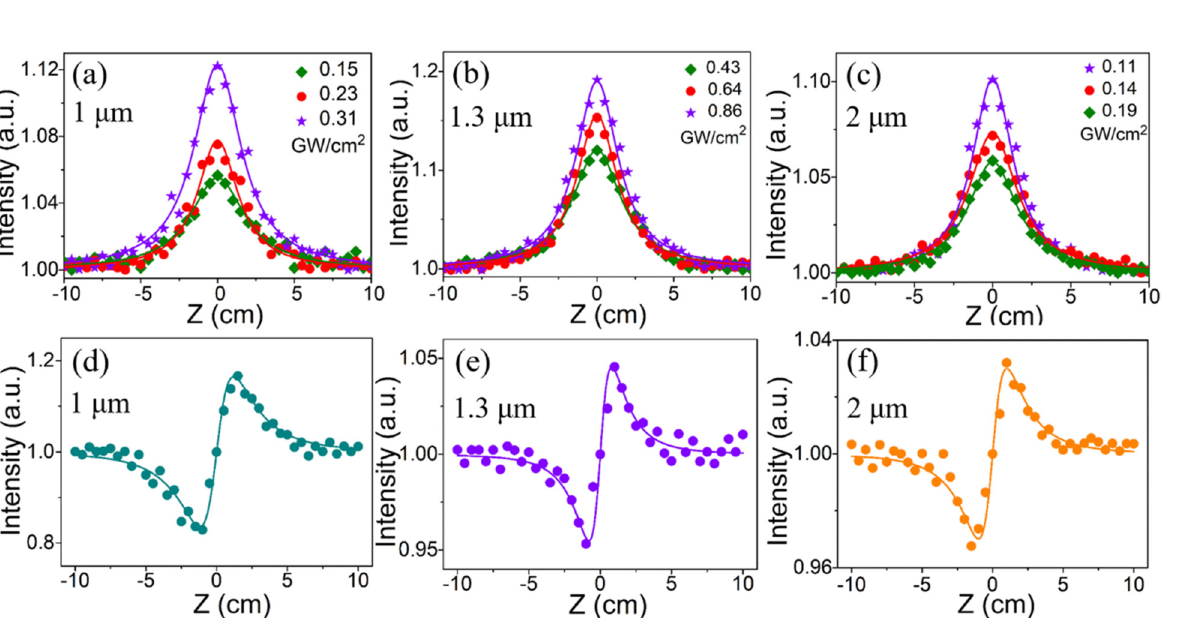
Figure 3: OA Z-scan results of S-C 3 N 4 at (a) 1.06, (b) 1.34, and (c) 1.87 μ m, respectively. CA Z-scan results of S-C 3 N 4 at (d) 1.06, (e) 1.34, and (f) 1.87 μ m,